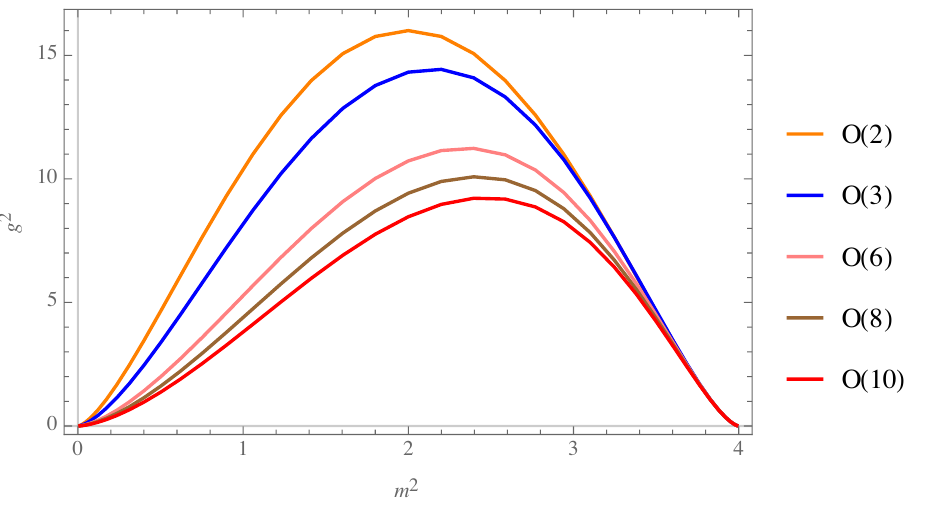
Figure 14 . Coupling bound to a ( t ) state with no extra bound